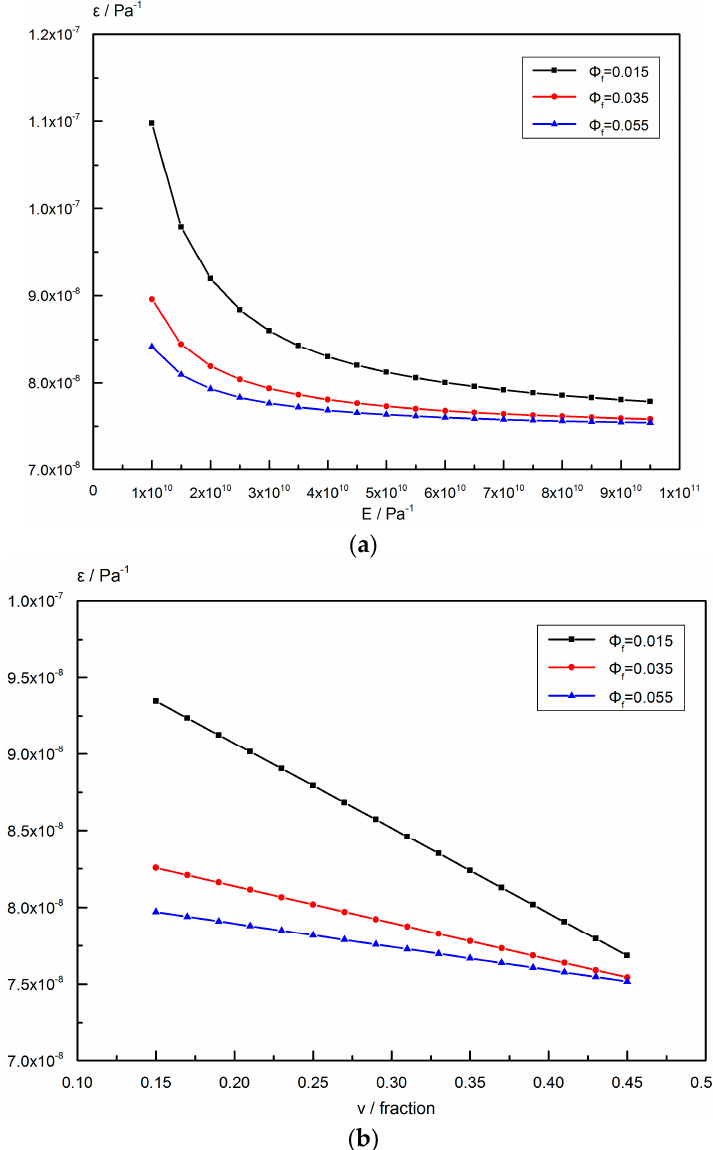
ε ) in North Truva field. ( a )